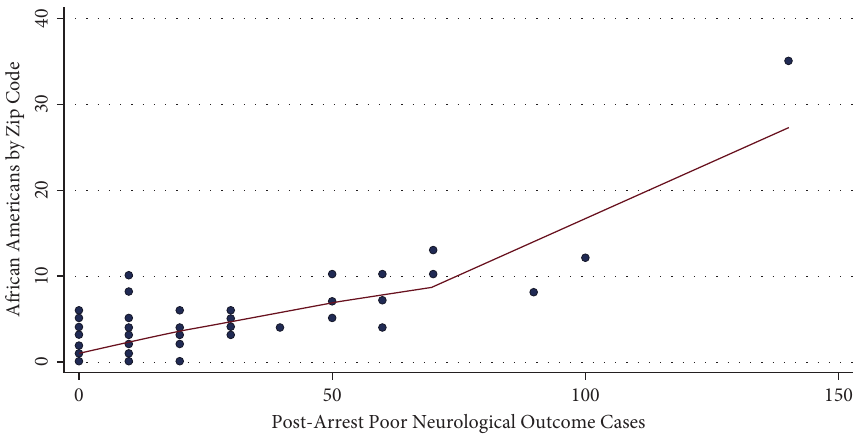
Figure 5: Association of African Americans versus poor neurologic outcomes after cardiac arrest by locally weighted regression (LOWESS) ( N � 3,952).